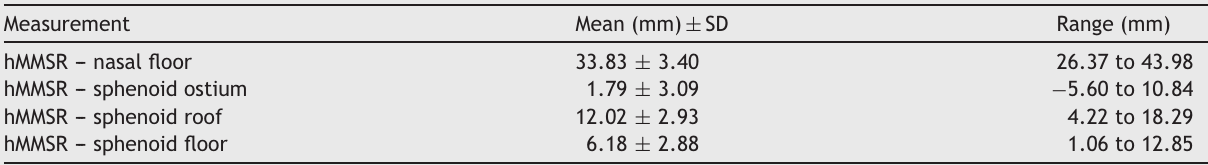
Summary of vertical distances in our